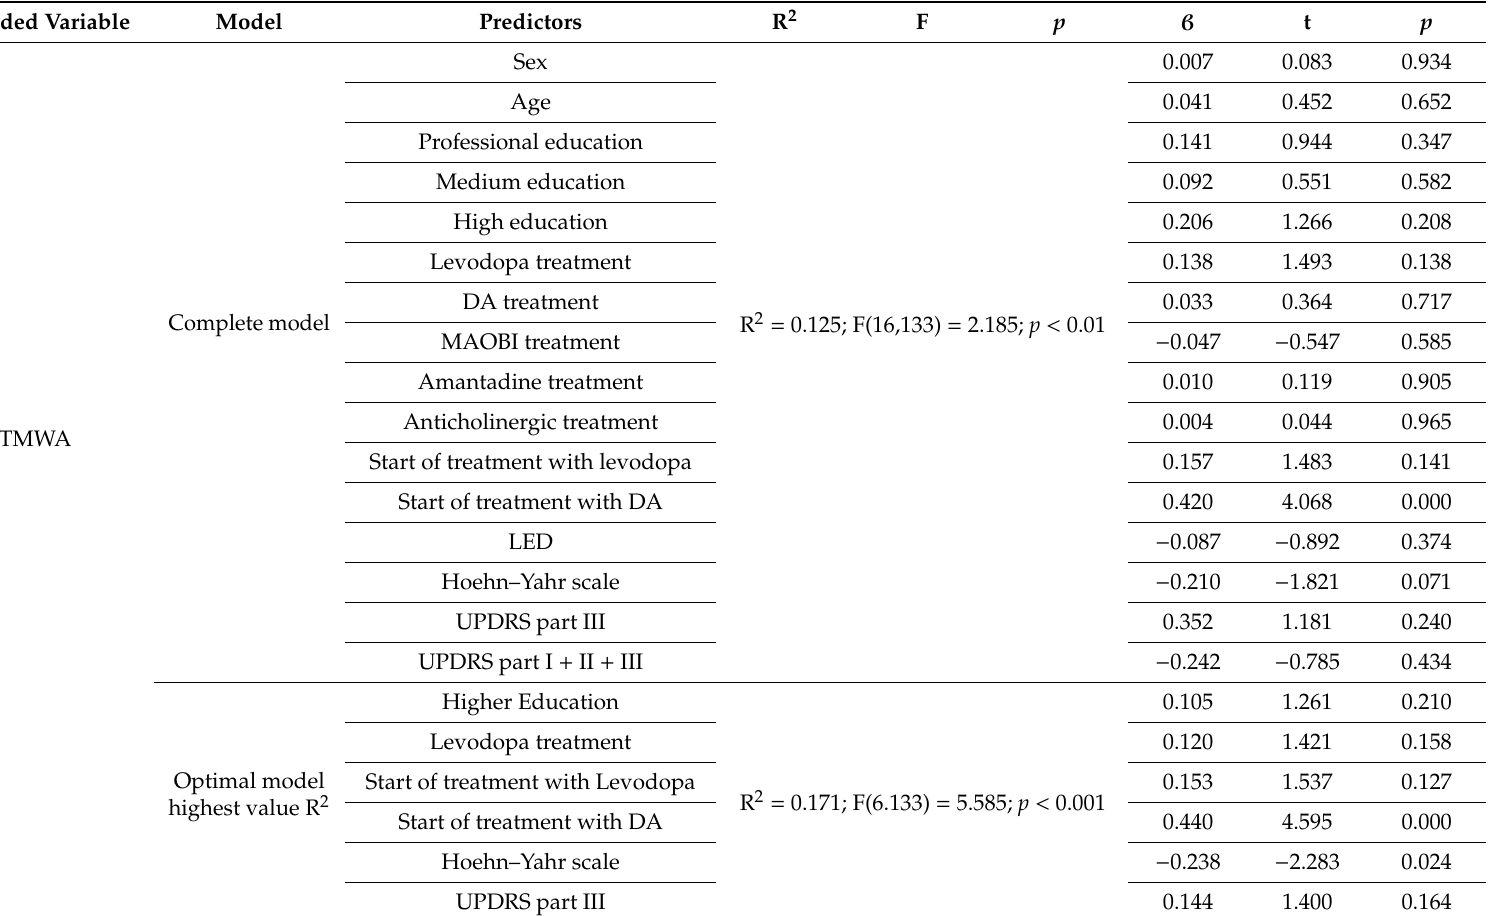
Table 3. Analysis of backward regression, which determines % of the variability of ITMWA, conditioned by the group of socio-demographic and clinical predictors in the group of patients with Parkinson’s disease.